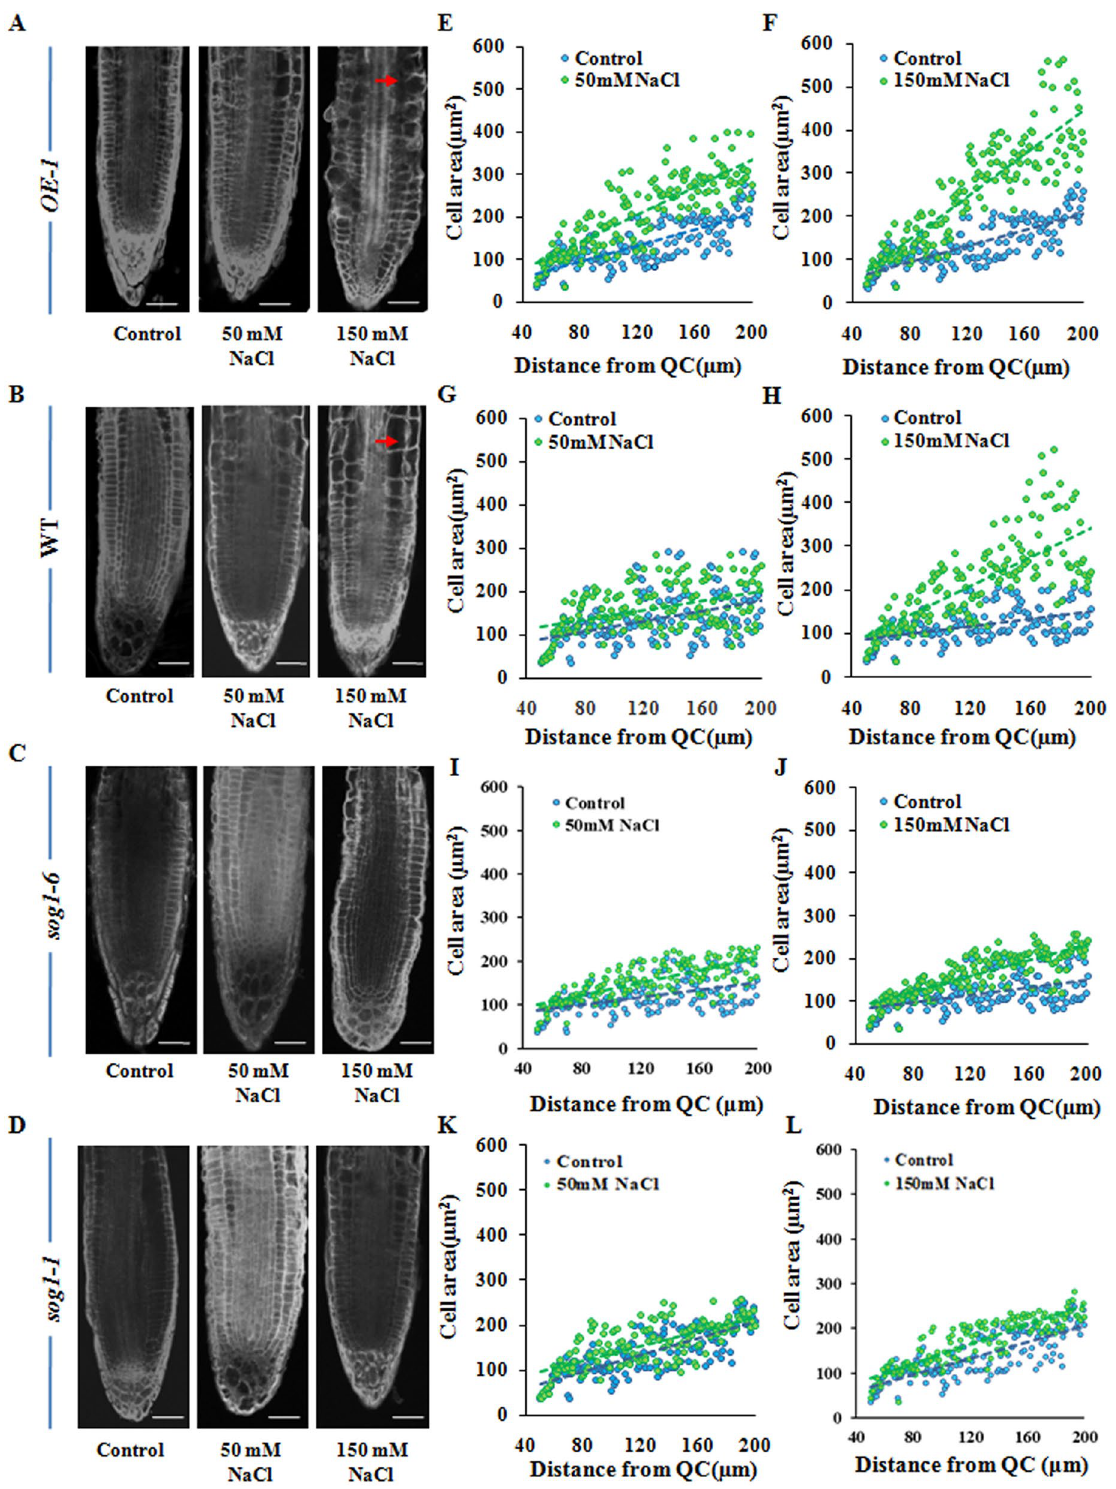
Figure 6. Salinity induced cell area expansion in the root tip epidermal cells. ( A – D ) Propidium iodide stained root tip cells of 7-days old OE-1 , wild-type, sog1-6 and sog1-1 mutant seedlings respectively, either treated without or with 50 and 150 mM NaCl. Red arrows showing increase in cell size. Scale bar: 50 μm. ( E – L ) Measurement of area of root tip cells situated between 40 and 200 μm from the quiescent centre (QC) using ImageJ software (NIH). Regression lines included in ( E – L ); For OE-1 ( E , F ), R 2 = 0.421 (Control), 0.598 (50 mM), 0.787 (150 mM); for wild-type ( G , H ), R 2 = 0.507 (Control), 0.617 (50 mM), 0.713 (150 mM); for sog1-6 ( I , J ), R 2 = 0.228 (Control), 0.236 (50 mM), 0.354 (150 mM) and for sog1-1 ( K , L ), R 2 = 0.181 (Control), 0.191 (50 mM), 0.204 (150 mM). The F value was found to be < 0.001 for all regression